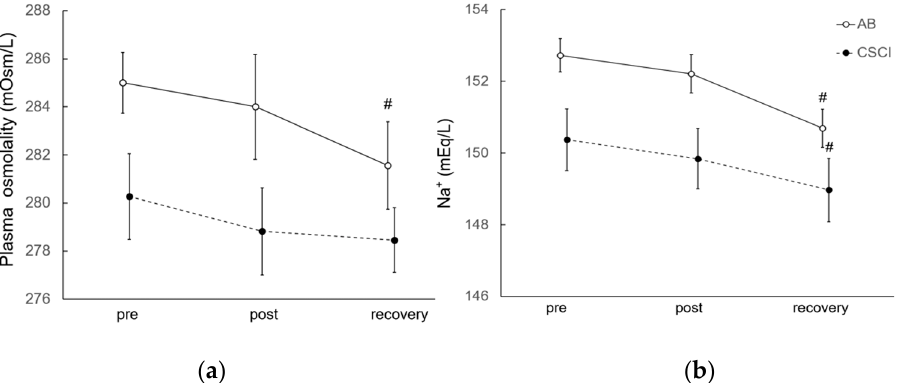
Figure 1. Plasma osmolality and Na + concentrations before (pre), immediately after (post), and 60 min after (rec) exercise. Data are mean ± SEM. # p < 0.05 vs. the pre value of the same subject group. AB: able bodied subjects, CSCI: cervical spinal cord injury. ( a ) Plasma osmolality; ( b ) Na + .